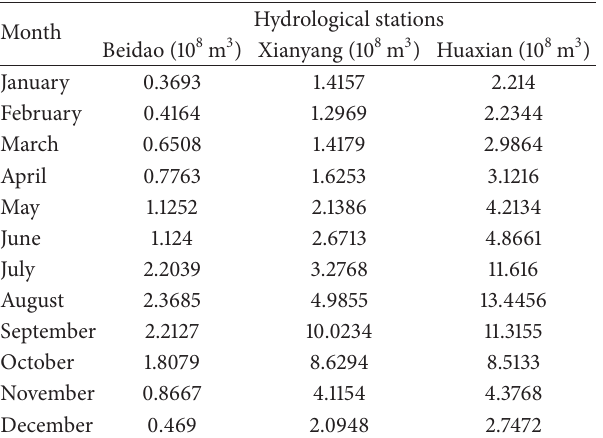
Table 1: The maximum instream ecological flow at three stations. Hydrological Month